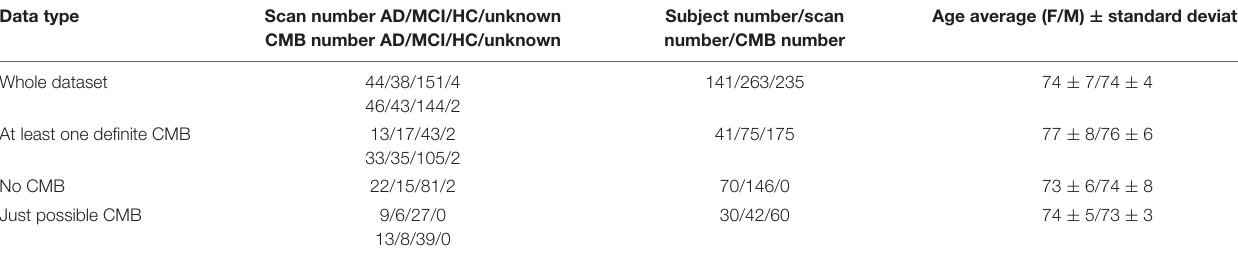
TABLE 1 | Gathered information from DS1.